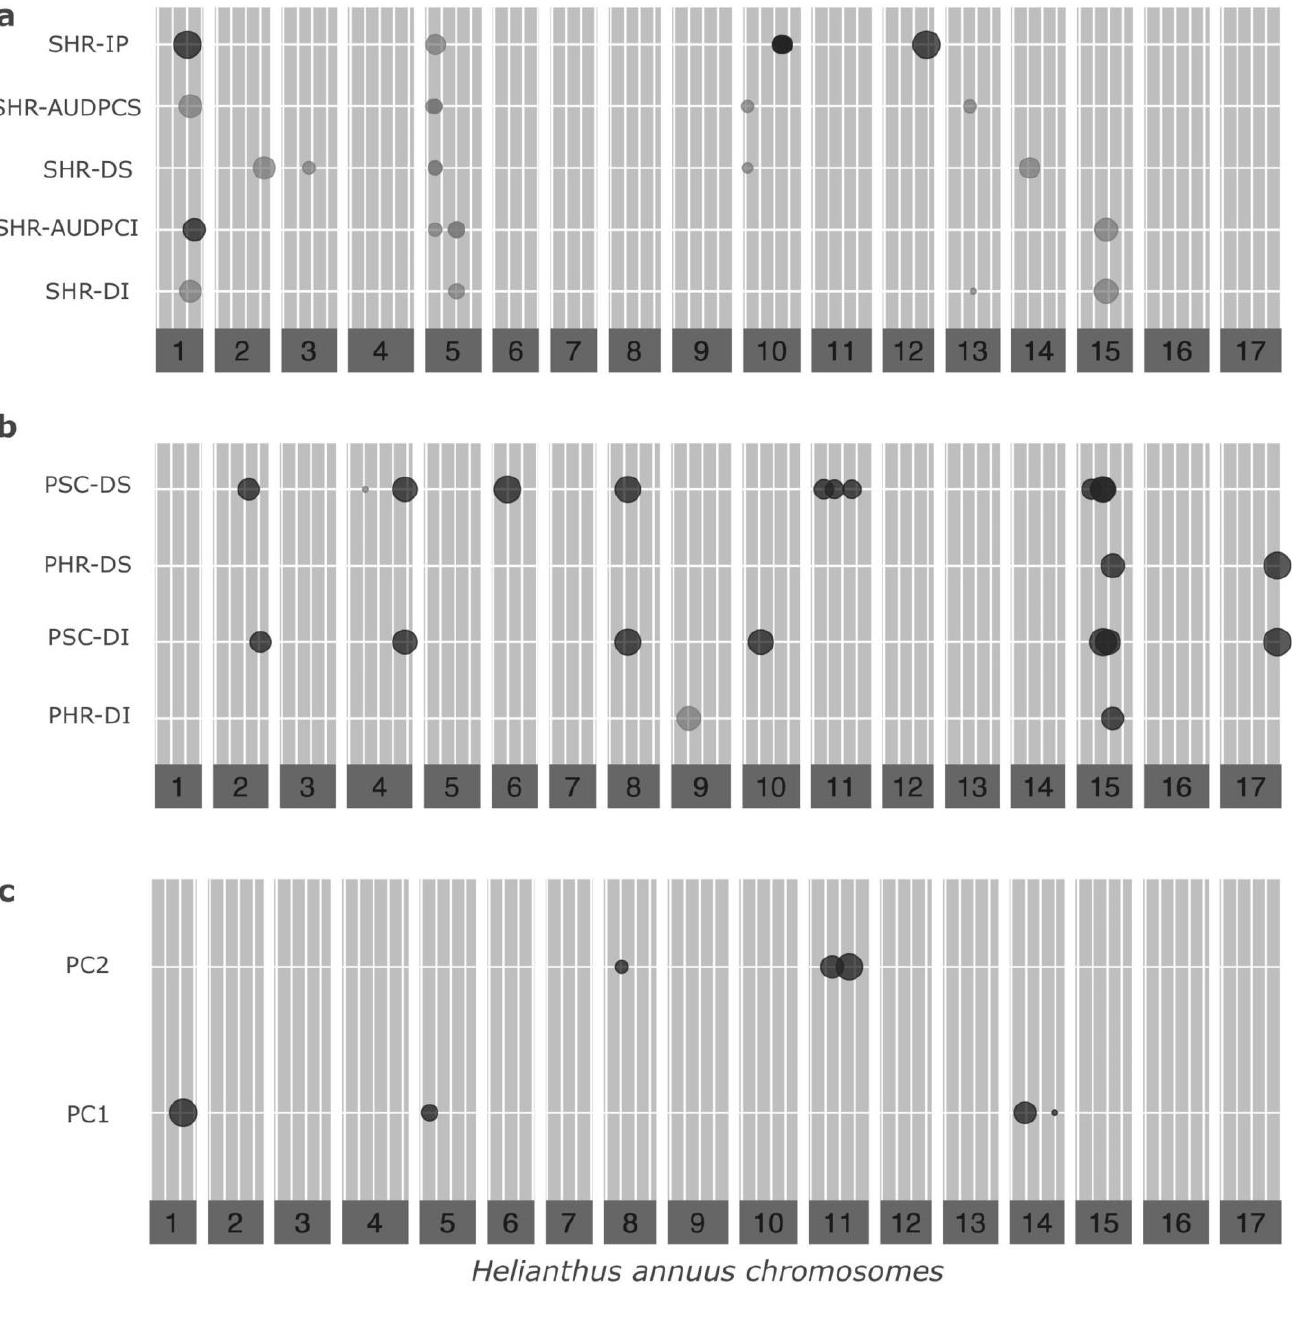
Figure 3. Plots of effect sizes for associated markers. Dot diameters are proportional to the effect size of the marker. ( a ) SNPs associated with phenotypic traits of SHR. DI, disease incidence; AUDPCI, area under the disease curve for DI; DS, disease severity; AUDPCS, AUDPC for DS; IP, incubation period. ( b ) SNPs associated with phenotypic traits of Diaporthe/Phomopsis. PHR, Phomopsis head rot; PSC, Phomopsis stem canker. ( c ) SNPs associated with principal components PC1 and PC2.